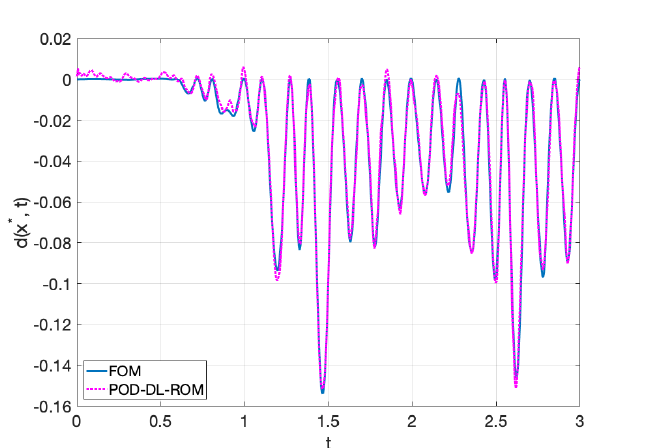
Figure 10. Test case 2: FOM and POD-DL-ROM displacement at x ∗ = ( 5.50,6.07 ) cm for the testing- = [ 2.7 × 10 6 g/(cm · s 2 ),0.375 ] parameter instance µ test